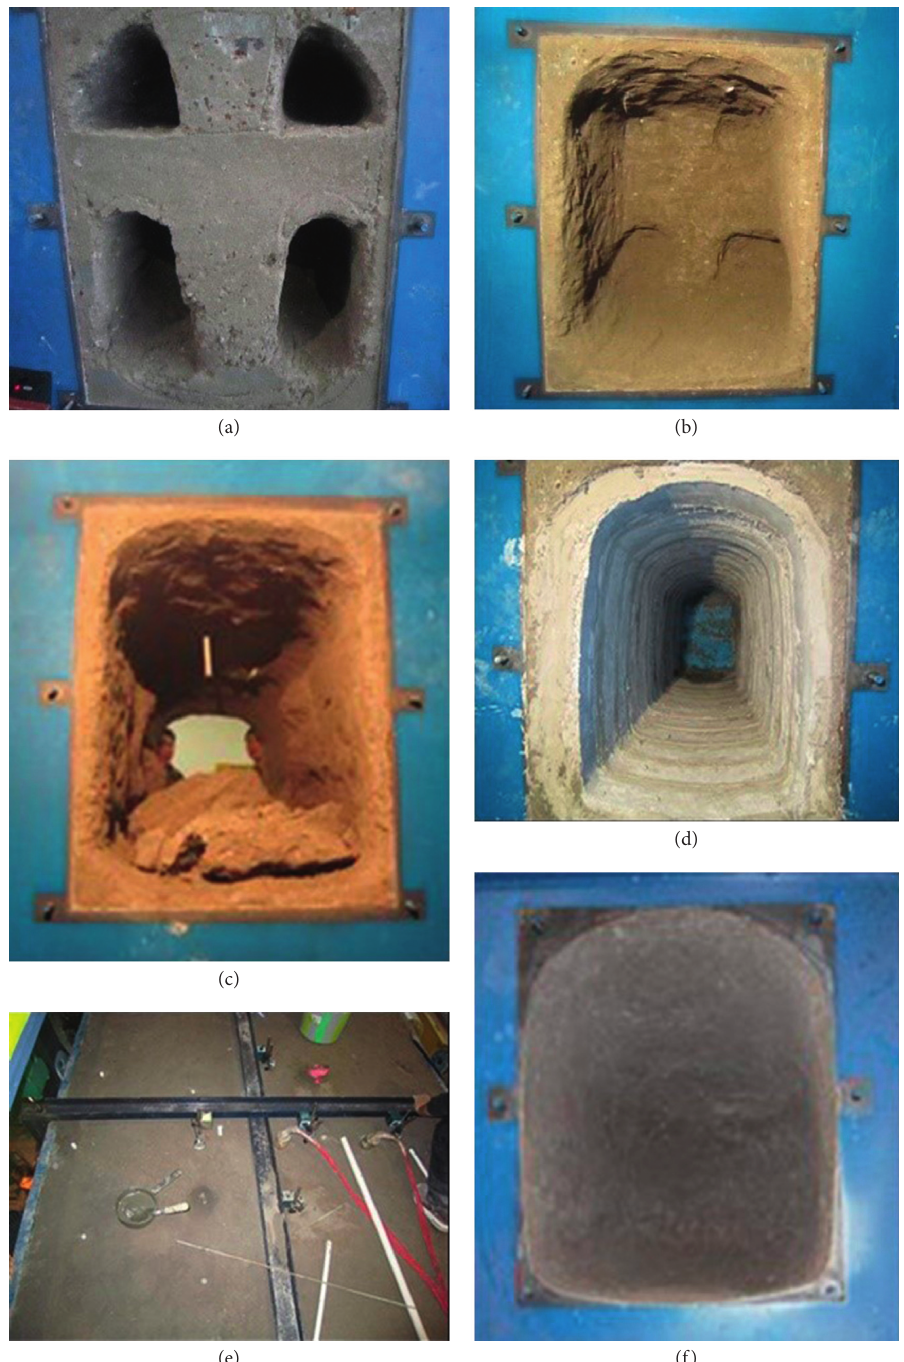
Figure 9: Model test excavation process: (a) step 1: four pilot headings when excavating the main tunnel for the first time; (b) step 4: excavating core soil and rock beam of the main tunnel for the second time; (c) step 6: excavating core soil and rock beam of the main tunnel for the third time; (d) step 9: secondary lining; (e) step 10: surface injecting; (f) step 14: fourth full-face excavation of the accessorial cross of different measuring points that varied with the exca- sidewall, HS-b1 to HS-b5 are stress meters of the sur- vation process are given by analyzing experiment data, as rounding rock of the main tunnel hance, and VS-b1 to VS- shown in Figure 12. b3 are stress meters of the surrounding rock of the main tunnel vault. IS-b1 to IS-b3 are stress meters of sur- rounding rock of the main tunnel invert. The stress curves